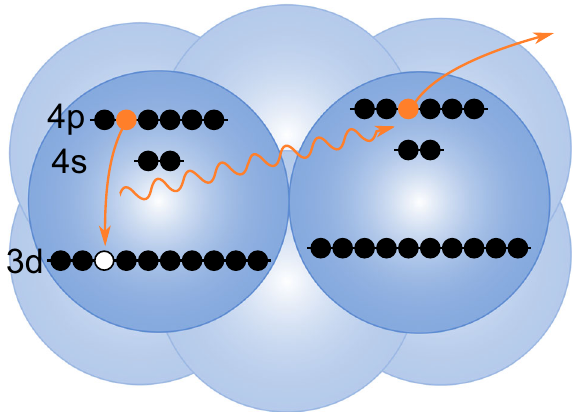
Fig. 1 Schematic representation of core-level ICD in Kr clusters. The black dots represent the electrons occupying the 3 d , 4 s , and 4 p shells in Kr, where fi ne structure splitting of the orbitals has been neglected for simplicity. The 3 d core vacancy (depicted as a white dot) is fi lled by a valence (4 p , orange dot) electron from the same atom, and the released energy is transferred to the neighboring atom, which is thereby ionized. The ICD electron is shown as an orange dot (4 p electron), leaving the second Kr